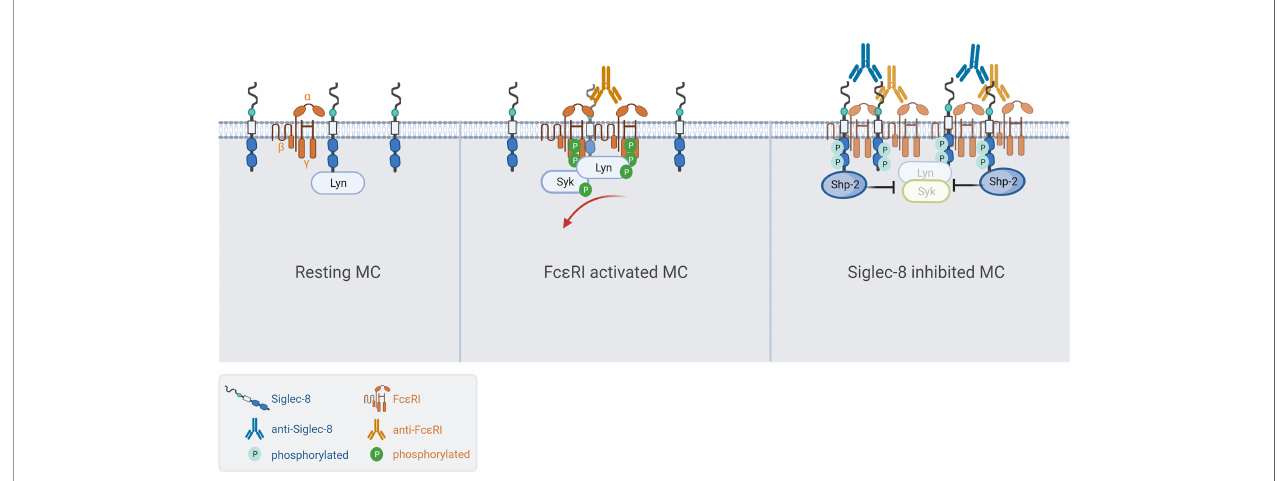
FIGURE 5 | Model of Siglec-8 mediated inhibition of Fc e RI signaling in MCs. (Left) Siglec-8 and Fc e RI are distributed along the membrane of resting MC while partially colocalizing. (Middle) Cross-linking with MAR-1 anti-Fc e RI results in high density clusters of Fc e RI resulting in phosphorylation at the ITAM, subsequent MC activation/degranulation and partial exclusion of Siglec-8 from the activating complexes. (Right) In the presence of Siglec-8 mAb, phosphatases like Shp-2 are recruited to large complexes of activating (Fc e RI) and inhibitory (Siglec-8) receptors resulting in potent inhibition of intracellular